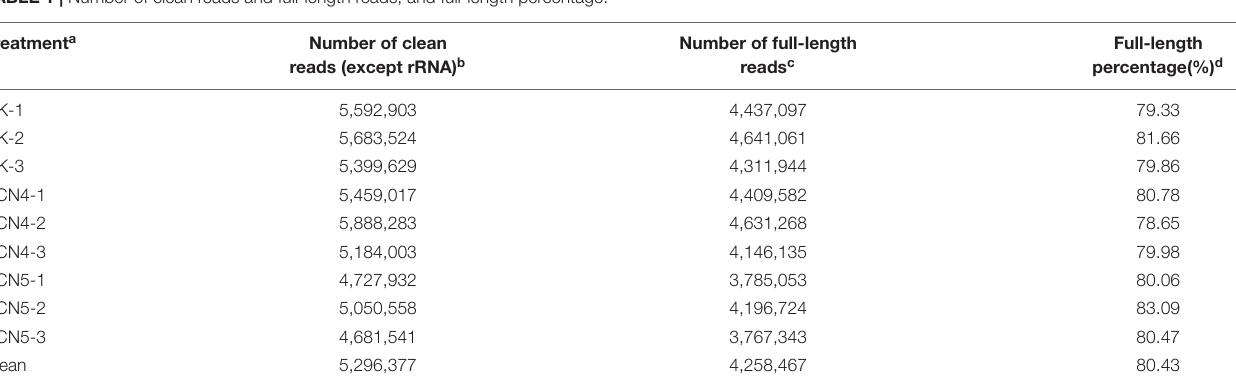
Number of full-length reads c